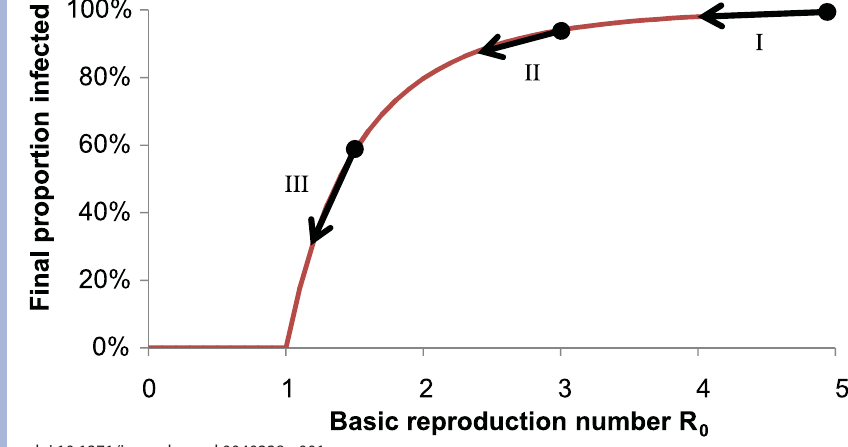
Figure 1. How the Effi cacy of Interventions That Limit Transmission Depends on the Basic Reproduction Number, R 0 The fi nal proportion infected in a pandemic for a general class of models with homogeneous population mixing is plotted as a function of R [22,23]. The arrows highlight the effect of an 0 intervention that reduces transmission by 20% for three different baseline values of R . This curve 0 can be used, for example, to predict the effect of a vaccine that directly protects 20% of individuals on those who are not directly protected. In scenario I, R is 5 and the intervention reduces the 0 attack rate by 1.3%. In scenario II, R is 3 and the reduction is 6.2%. In scenario III, R is 1.5 and the 0 0 reduction is